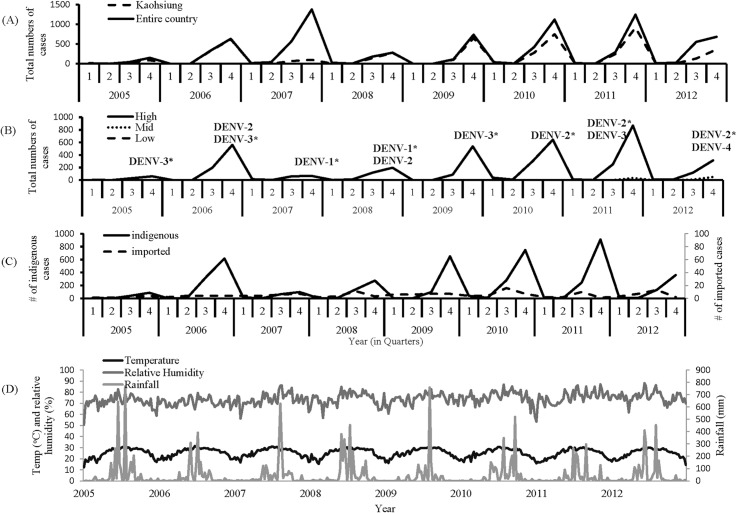
Secular trend of the meteorological data and the dengue cases from 2005 to 2012.(A) Comparison between Kaohsiung city and whole Taiwan of all laboratory-confirmed indigenous dengue cases from 2005 to 2012 based on the residential area. (B) Comparison among high, middle and low risk areas of all laboratory-confirmed indigenous dengue cases from 2005 to 2012. All dengue virus serotypes detected during each epidemic was indicated accordingly, with the dominant serotype labeled with asterisk based on the major serotype detected from more than 80% of dengue cases in the specific year. (C) The quarterly total numbers of the laboratory-confirmed imported and indigenous dengue cases in Kaohsiung city from 2005 to 2012. (D) The weekly average of temperature (temp, oC), rainfall (rain, mmHg) and relative humidity (rh, %) from 2005 to 2012.